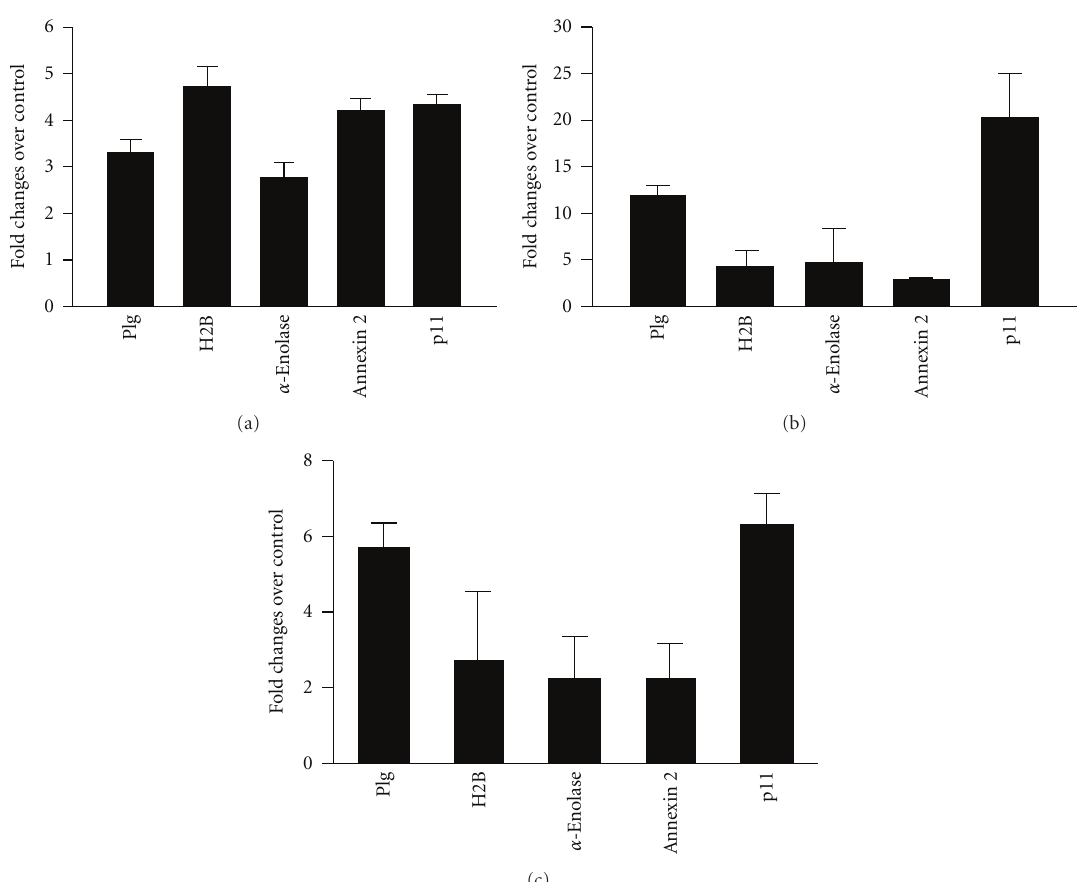
Figure 2: THP-1 (a), (b) and U937 (c) cells were either di ff erentiated with IFN γ + VD3 for 48 h (a) or induced to undergo apoptosis with camptothecin for 24h (b), (c). Cells are labeled with Alexa-488-Plg or anti-Plg-Rs antibodies against H2B, α -enolase, annexin A2, and p11 followed by Alexa-488-ant-rabbit IgG (c) and analyzed by FACS. Early apoptotic populations are used to analyze the data. Data are means ± SD of two to three independent experiments and presented as the fold change relative to untreated THP-1 or U937 cells. Besides annexin2, other plasma membrane proteins,